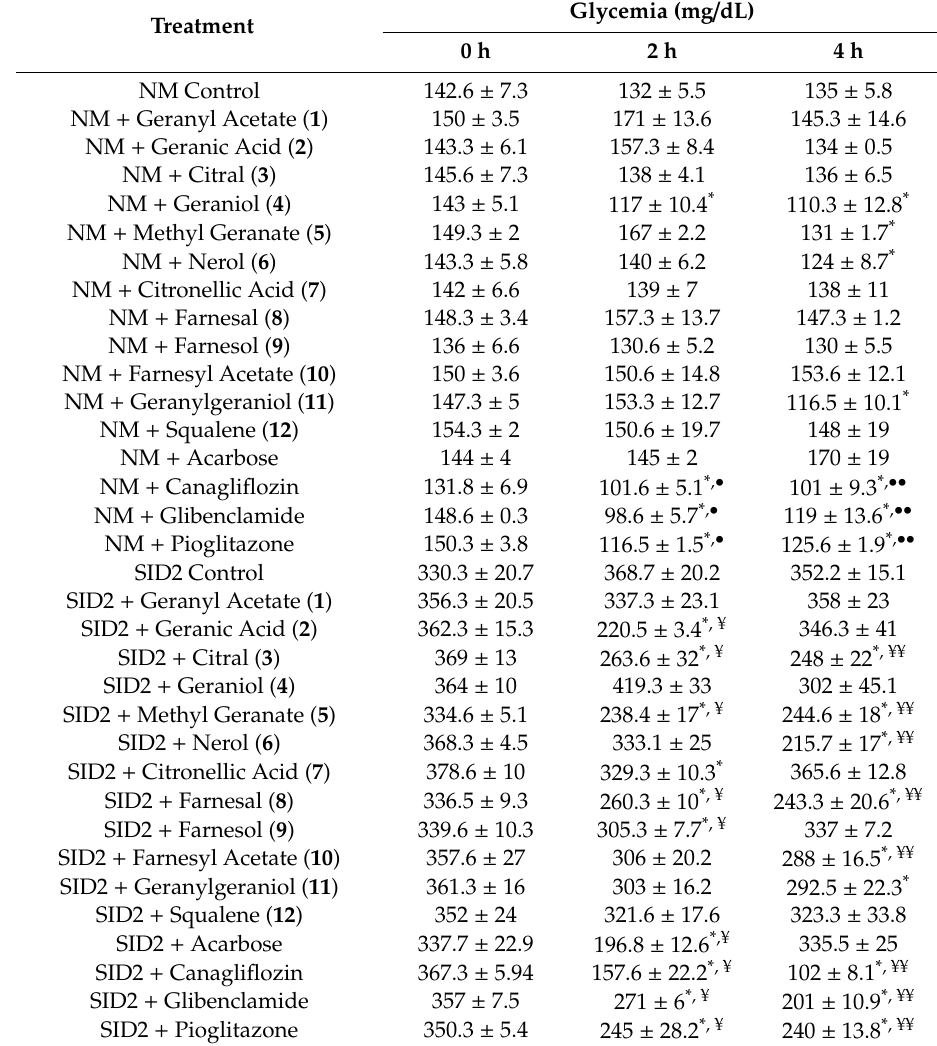
Table 1. E ff ect of a single oral administration of the compounds on the blood glucose levels of normoglycemic mice (NM) and streptozocin-induced type 2 diabetic mice